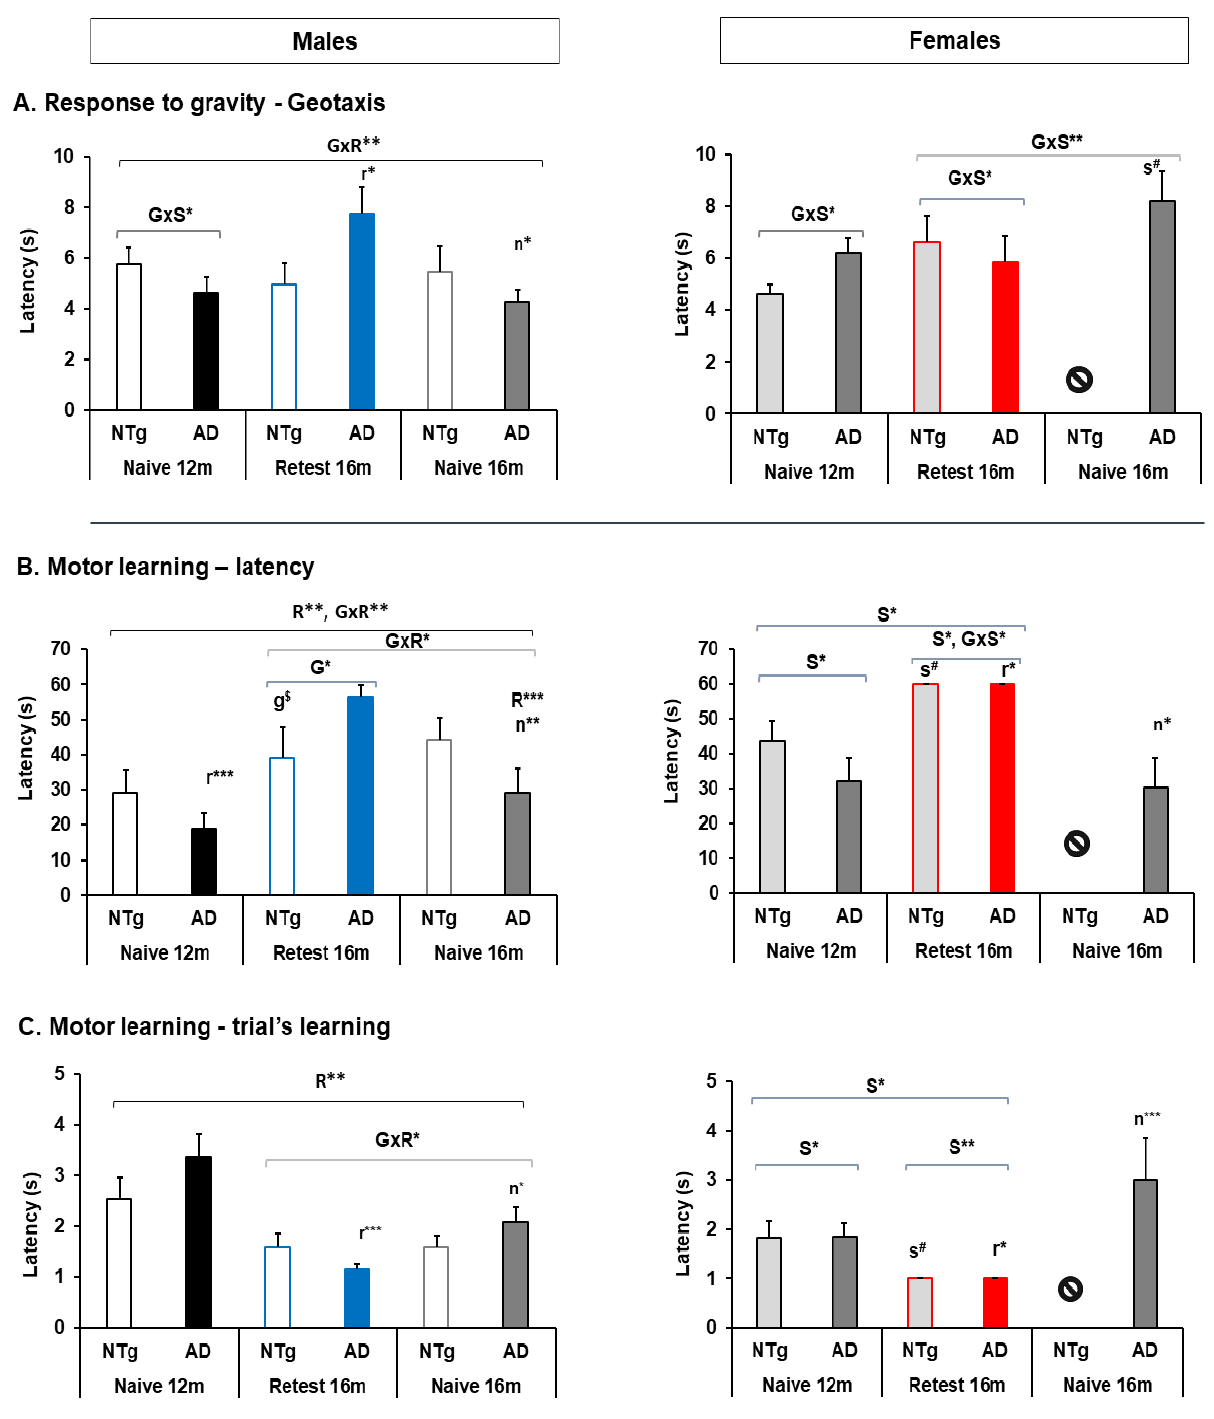
Figure 5. Geotaxis and motor learning — rotarod. ( A ) Geotaxis, ( B ) latency, ( C ) t rial’s learning. Statistics: ANOVA, G, genotype effect, G* p < 0.05. S, sex effect, S** p < 0.01, S* p < 0.05. R, Re-test effect, naïve 12 months and re-test 16 months, R** p < 0.01**, R* p < 0.05*. G×S, genotype and sex interaction effects, G×S** p < 0.01**, G×S* p < 0.05*. G×R, genotype and re-test effects, G×R** p < 0.01**, G×R* p < 0.05*. Bonferroni post hoc test: g, genotype, s, sex, r: re-test naïve 12 months vs.16 months, and n, naïve 16 months vs . re-test 16 months; $ expressed genotype, and # expressed sex differences between genotypes. The symbol ⦸ indicates the absence of the group, and m, month.